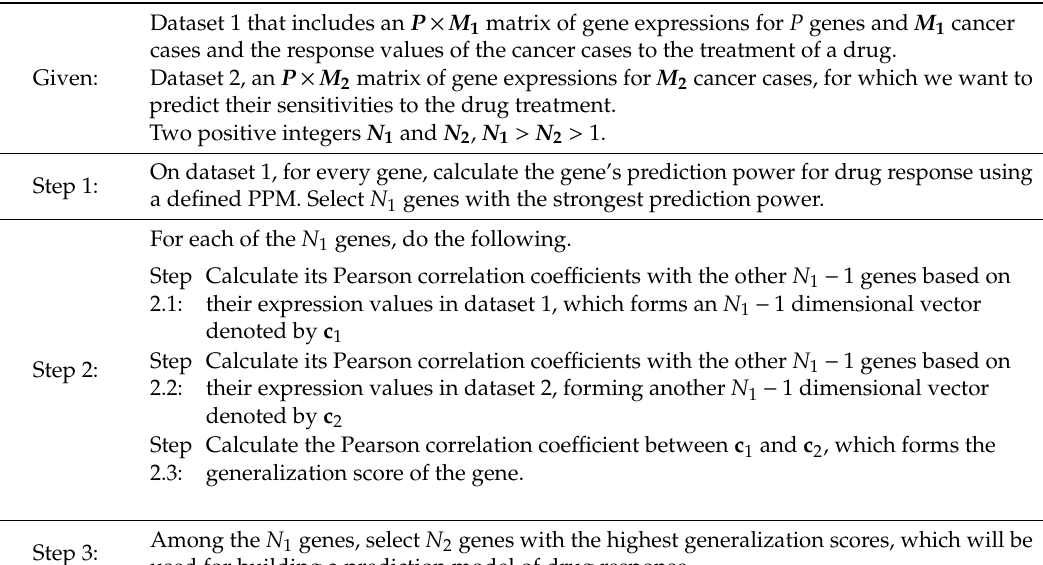
Figure 1. Analysis flowchart of the COXEN framework. The original COXEN method and the enhanced COXEN method are different in the two boxes with dashed line border. Table 1. The original COXEN gene selection method.